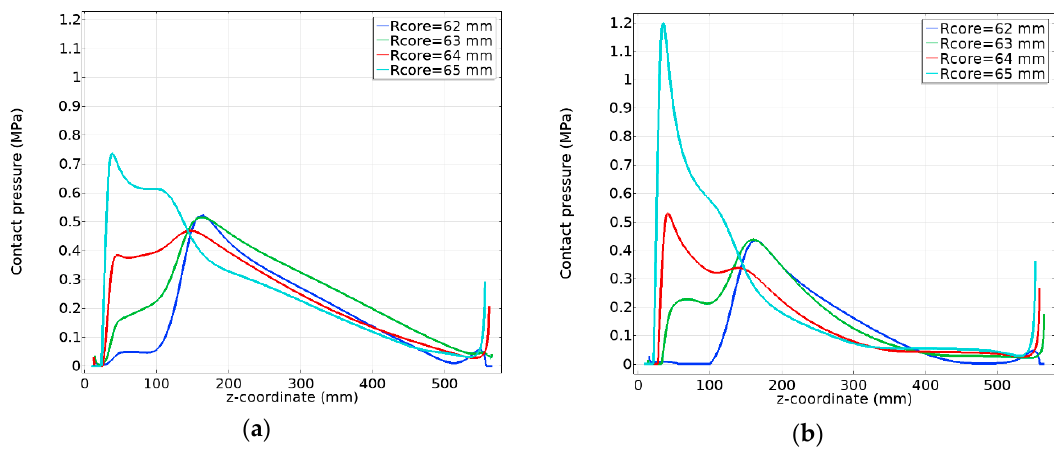
Figure 12. The contact pressure distributions between the stress cone and the cable core with friction coefficients of 0.2 and 0.4 are presented in ( a ) and ( b ), respectively. For each curve, the total spring force is controlled at 30 kN.